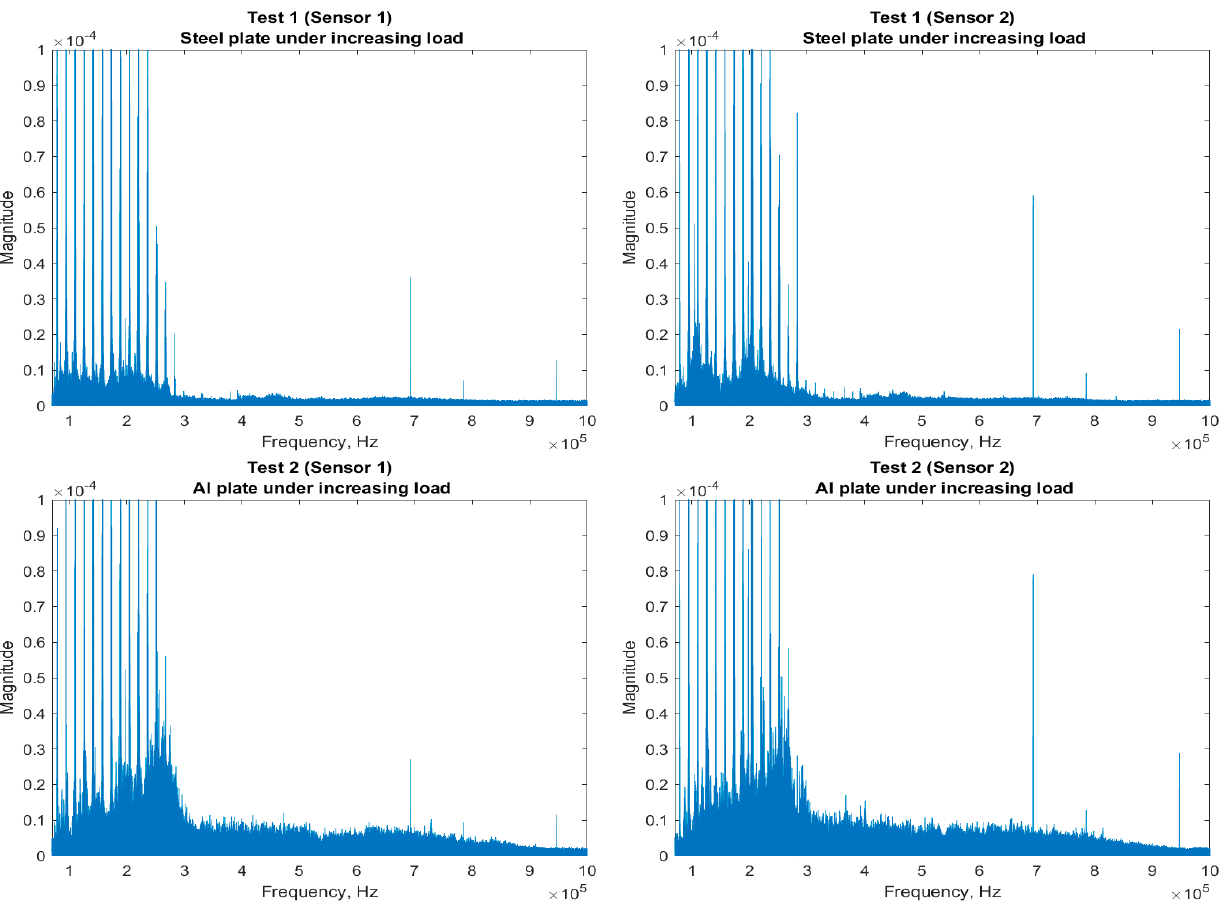
Figure 9. FFTs of tool steel indenter on steel sheet (top) and tool steel on aluminium sheet (bottom) under increasing load for scratch tests. (left), sensor 1. (right), sensor 2.